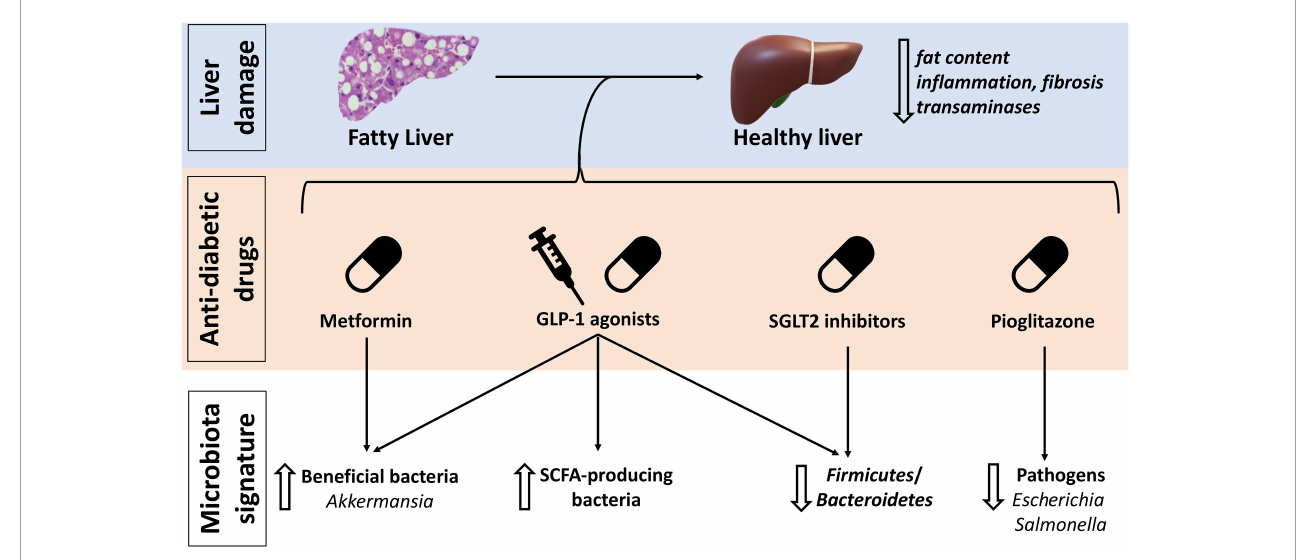
FIGURE3 Anti-diabetic drugs effects on non-alcoholic fatty liver disease (NAFLD) and gut microbiota. GLP-1, glucagon-like peptide 1; SCFA, short-chain fatty acids; SGLT, sodium-glucose cotransporter inhibitors.